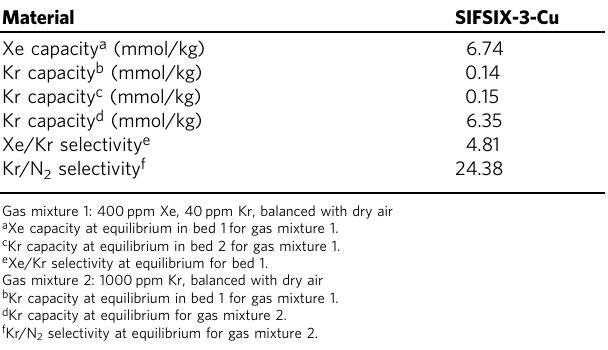
Table 1 Xe and Kr separation performance parameters for SIFSIX-3-Cu at 298 K and 1